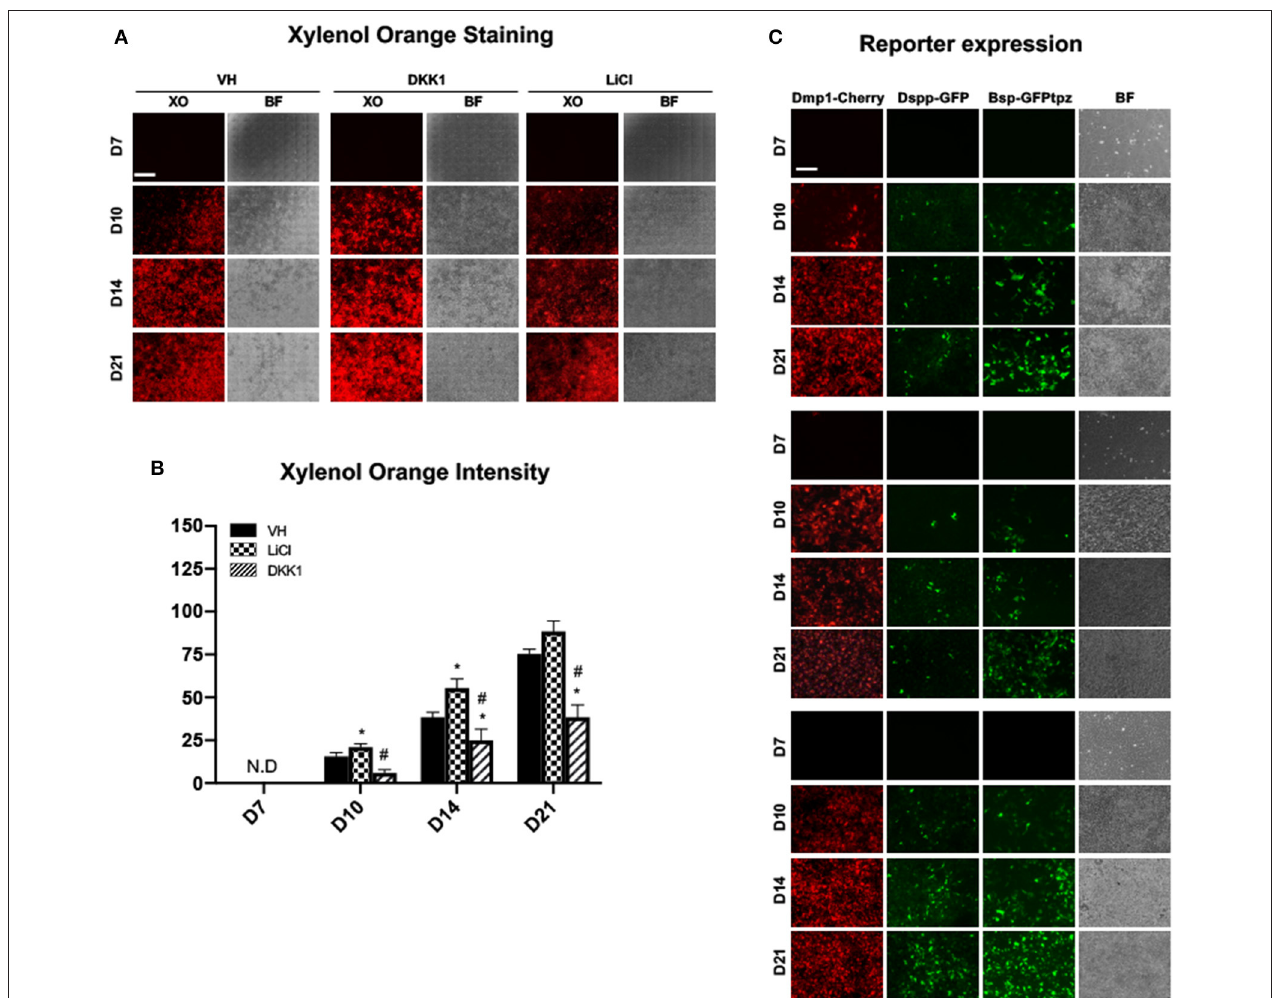
FIGURE 6 | Effects of early exposure to LiCl on mineralization and tissue- and stage-specific reporters in primary dental pulp cultures. Primary pulp cultures were treated with VH (0.1% BSA), DKK1 (50ng/ml) or LiCl (10mM) during the proliferation phase of in vitro growth between days 3 and 7. (A) Representative images of the same areas in cultures treated with VH, DKK1, and LiCl analyzed under brightfield (BF) and epifluorescent light using TRITC red filter for detection of XO staining. Scale bar = 2mm. (B) Graphs showing changes in the intensity of XO staining (in absolute values) in cultures treated with VH, DKK1, and LiCl. Early exposure increased XO staining at days 10 and 14. The intensity of XO staining was measured at 570/610-nm wavelength (excitation/emission) and at a gain of 80. Background fluorescence for XO was measured using cultures without the addition of ascorbic acid and β -glycerophosphate, which lack mineralization potential. The background fluorescence values were subtracted from respective XO measurements. Results represents mean ± SEM of at least 3 independent experiments. Analysis was performed using 1-way analysis of variance. * P ≤ 0.05 relative to VH at each time point; # P ≤ 0.05 relative to LiCl at each time point. XO, Xylenol orange; N.D, not detected. (C) Representative images of the cultures from DMP1-Cherry/DSPP-Cerulean and BSP-GFPtpz transgenic mice treated with VH, DKK1, and LiCl and analyzed under brightfield (BF) and epifluorescent light for the detection of DMP1-Cherry, DSPP-GFP, and BSP-GFPtpz. Early exposures to LiCl increased DMP1-Cherry and DSPP-GFP expression, which were decreased in DKK1 treated cultures. Early LiCl and DKK1 treatments increased and decreased BSP-GFPtpz expression, respectively. Scale bar = 200 µ m. XO, Xylenol orange; N.D, not detected; VH, vehicle; GFP, green fluorescent; GFPtpz, topaz variant of